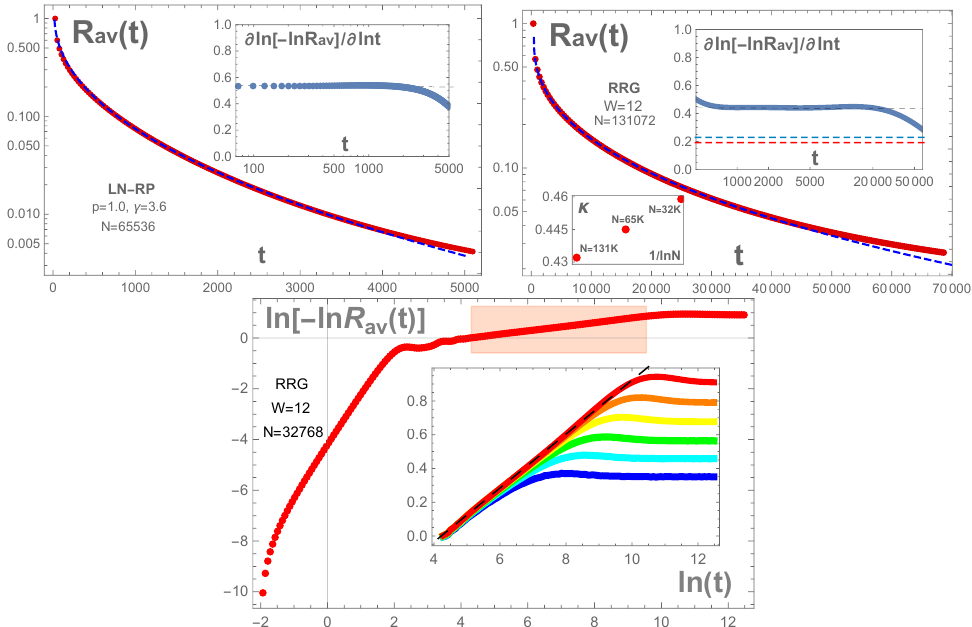
Figure 8: (Color online) The survival probability in a “multifractal” RP ensem- ble and in the Anderson model on RRG . (Upper-Left panel) : The survival prob- ( t ) for the logarithmically-normal RP model, Eq. (47) with p = 1, in ability R av the weakly-ergodic phase, γ = 3.6 and N = 65536, as a function of time. The main plot is obtained by the numerical Fourier transform of the “low-energy” part of the eigenstate overlap correlation function K ( ω ) shown in Fig. 9 in Appendix A. In ( t )] / d ln t demonstrates the inset: the plateau in the log-log derivative d ln [ − ln R av the region of the stretch-exponential behavior. The blue dashed line on the main ( t )] ∝ − t κ corresponding to the plateau value of plot shows the power-law ln [ R av κ ( N ) ≈ 0.53. (Upper-Right panel) : the stretch-exponential behavior of R ( t ) for av RRG with W = 12 and N = 131072. For 2000 (cid:174) t (cid:174) 40000 it is well approximated by the stretch-exponential function with κ ( N ) = 0.44 (blue dashed line on the main plot and the black dashed line in the inset). This value of κ ( N ) suffers from strong finite-size effects and decreases linearly with 1 / ln N as N increases (see lower in- set). Extrapolation to N → ∞ gives κ = 0.23 (blue dashed line in the upper inset) = 0.19 (red dashed line in which fits reasonably well the “theoretical” value κ theor the upper inset). (Lower panel) : the results of direct exact diagonalization numer- ( t ) for RRG with W = 12, N = 32768 in the time domain. The region ics for R av of the stretch-exponential behavior is shown by a pink rectangle. The inset shows the extension of the domain with the stretch-exponential behavior as the system size N = 1024 − 32768 (from blue to red)